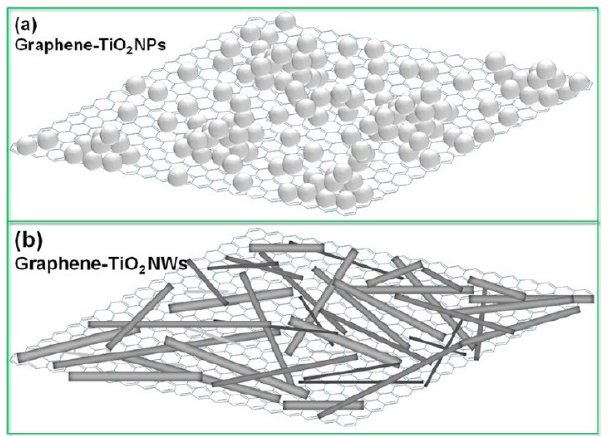
Figure 9. Schematic drawings of: ( a ) titania NPs aggregated on graphene; ( b ) titania nanowires dispersed uniformly on graphene. Reprinted with permission from [44]. Copyright (2012) ACS.